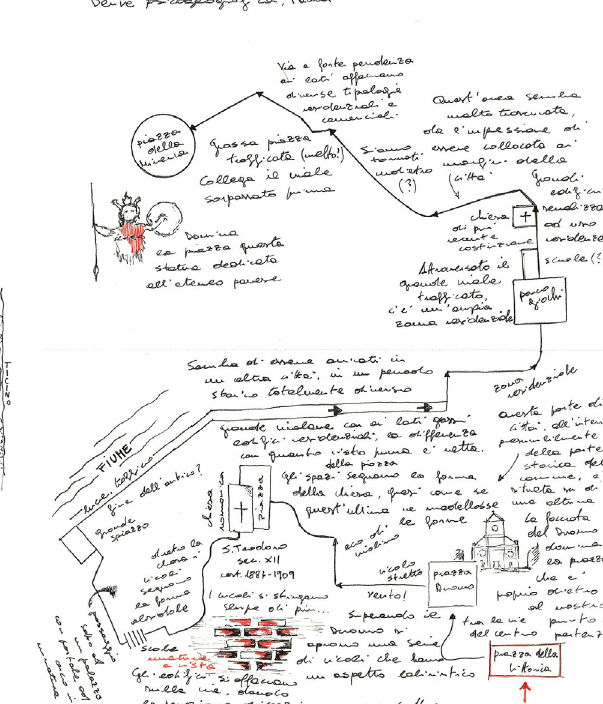
Annotations from one of the dérive walks and drifting in FIG. 2 town (image by Francesco Cavalloro, Alberto Pettineo).